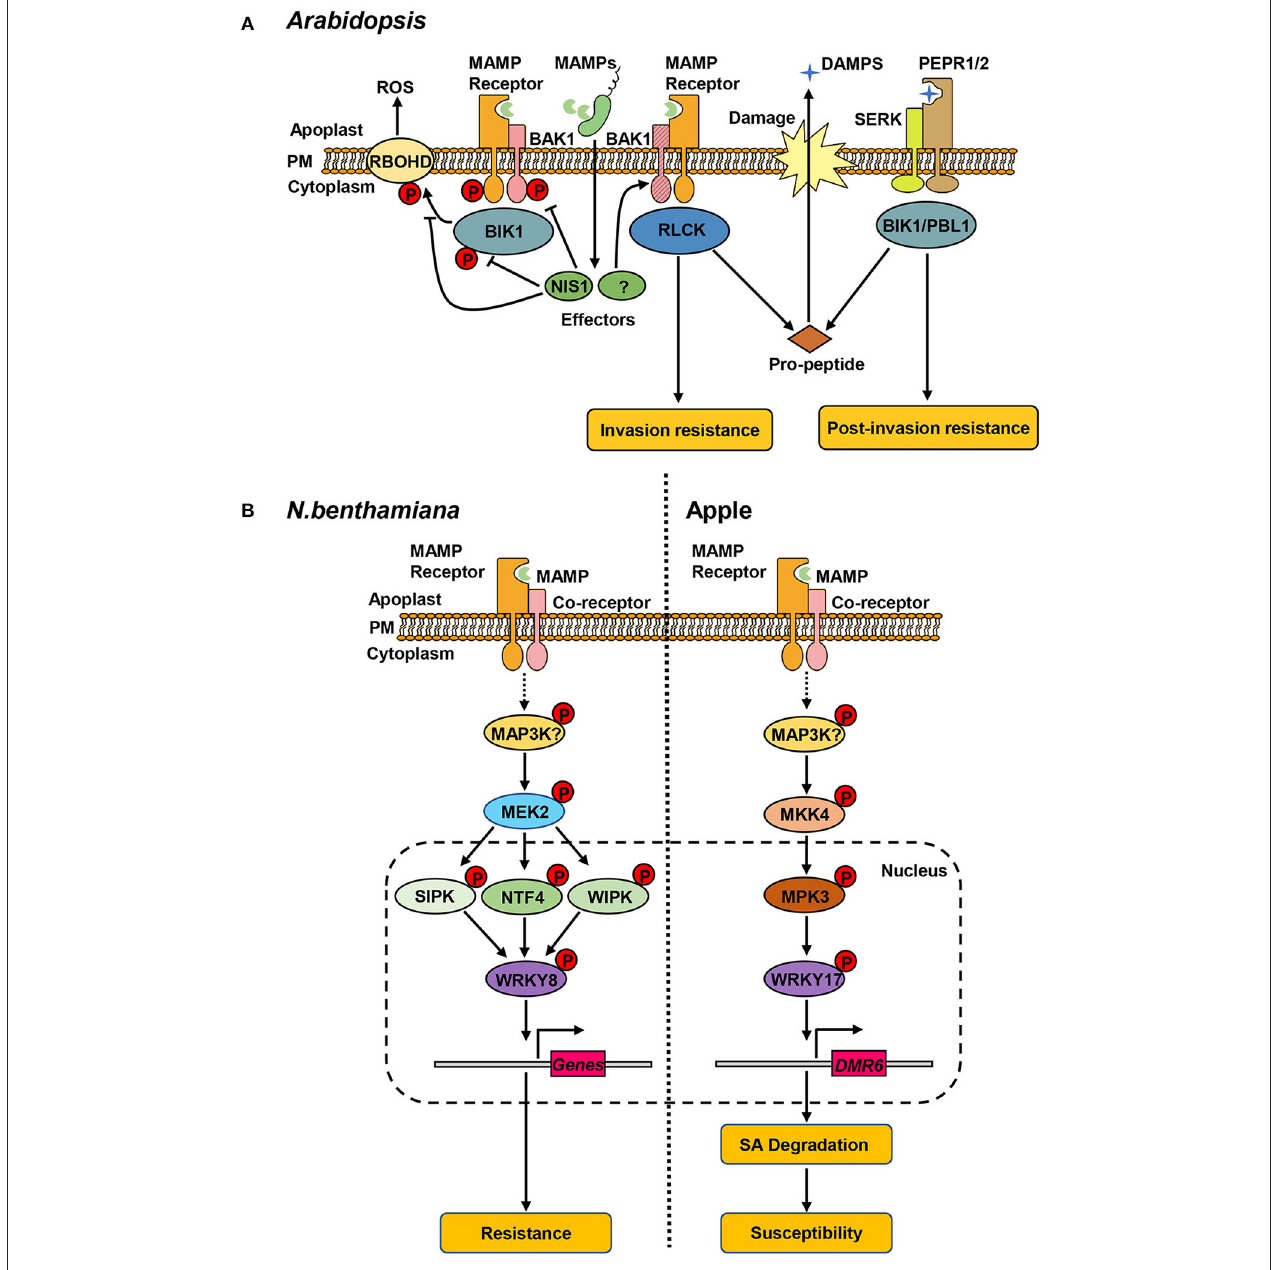
FIGURE 1 | Protein kinase-mediated signaling pathways in plant hosts. (A) Receptor kinases associated with resistance against C. higginsianum in Arabidopsis . Perception of microbe-/damage-associated molecular patterns (MAPMs/DAMPs) by cognate receptors (MAMP receptors, PEPR1/2) leads to the association of co-receptors (BAK1, SERK) and receptor-like cytoplasmic kinases (RLCKs, BIK1), and transphosphorylation within the complex. The phosphorylated BIK1 dissociates from the complex and phosphorylates RBOHD, triggering the production of ROS. Pathogen delivers the effector protein (NIS1) that inhibits the kinase activity of BAK1 and BIK1 and blocks the interaction of BIK1-RBOHD. BAK1 contributes to invasion resistance and is targeted by unknown effector(s) for degradation. BAK1 depletion results in increased release of PROPEP-derived DMAPs, activating the PEPR-mediated pathway that is required for post-invasion resistance. (B) MAPK-mediated defense responses in N. benthamiana and apple. Left: in N. benthamiana , pathogen recognition leads to activation of NtMEK2 by unidentified MAP3K(s). Activated NtMEK2 phosphorylates and activates downstream NtSIPK, NtNTF4, and NtWIPK, which interact with and phosphorylate transcription factor NtWRKY8. NtWRKY8 binds to the promoter of its target genes-related to resistance against C. orbiculare . Right: in apple, the MdMEK4-MdMPK3 cascade phosphorylates MdWRKY17 in response to C. fructicola . The phosphorylation of MdWRKY17 increases its binding to the promoter of MdDMR6, which promotes SA degradation and increases susceptibility to C. fructicola